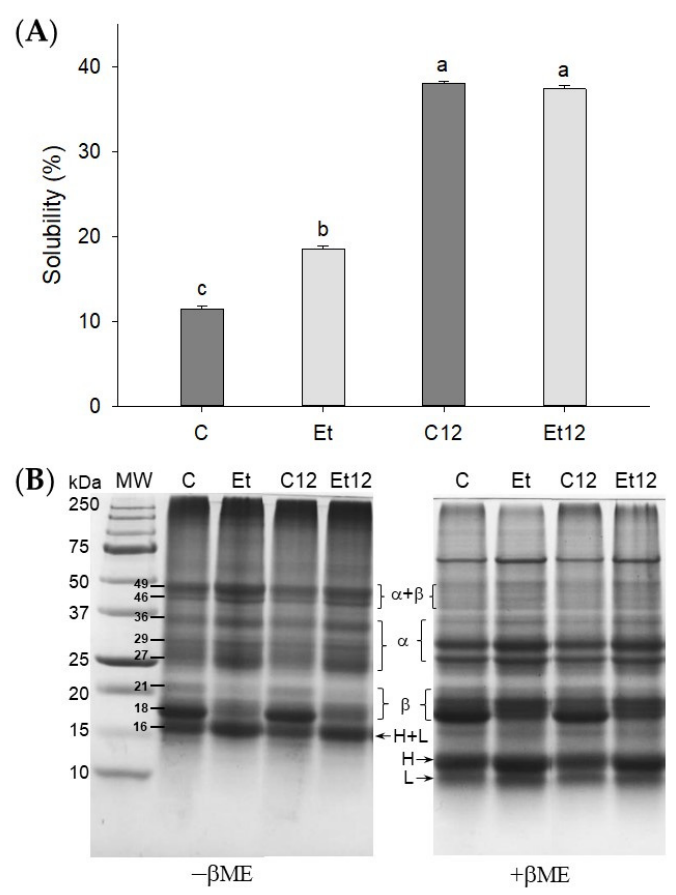
Figure 2. Protein solubility ( A ) and SDS–PAGE ( B ) of dephenoled CPI without or with ment. Samples C: control; Et: dephenoled with 70% ethanol; C12 and Et12: pH 12 shift treated samples. pH 12 shift treatment. Samples C: control; Et: dephenoled with 70% ethanol; C12 and Bar values with different letters (a–c) are significantly different ( p < 0.05). β ME: β -mercaptoethanol; Et12: pH 12 shift treated samples. Bar values with different letters (a–c) are significantly MW: molecular weight standard; α , β , H, and L: subunits of different ( p < 0.05). β ME: β -mercaptoethanol; MW: molecular weight standard; α , β , H, and L: subunits of CPI.